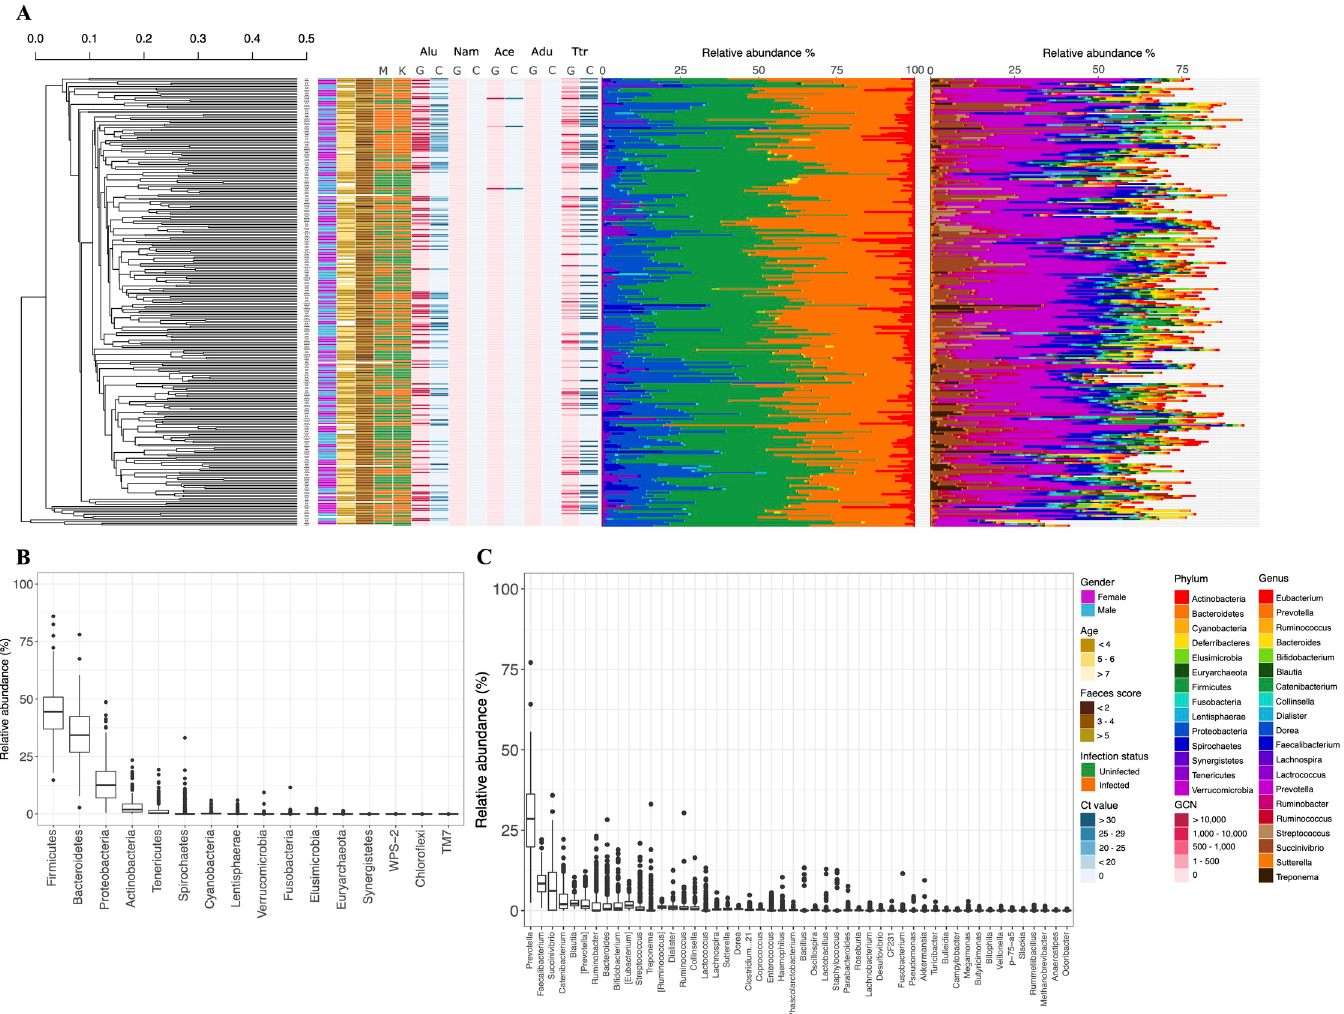
Fig 1. Bacterial gut community abundance to phyla and genera level, hierarchical clustering, soil-transmitted helminth infection status by microscopy (Kato Katz thick smear) and multiplexed-tandem qPCR (MT-PCR), sex, age and faecal score are depicted in the above figure (A) (adapted from Rosa et al . 2018 [11]). Infection intensity classification is depicted in MT-PCR gene copy number output and cycle threshold (Ct) values separated after species-specific infections: Ascaris lumbricoides (Alu), Necator americanus (Nam ) , Ancylostoma ceylanicum (Ace), Ancylostoma duodenale (Adu) and Trichuris trichiura (Ttr) (from left to right). Scale bar represents evolutionary distance. Relative abundance is visualised in percentage of all bacterial phyla (B) and the top 50 bacterial genera (C). Abbreviations within the figure for schools are KK: Krae Khi, MN: Mae Nil, MNK: Mae Nil Khi, HM: Huay Manhok, HMK: Huay Manhok Khi, MSK: Mae Salid Khi, MK: Mae Kho, MSN: Mae Salid Noi, MS: Mae Song, MSL: Mae Salid Luang and TMKT: Thi Mo Ko Tha; and for diagnostics K: Kato Katz thick smear, M: MT-PCR, G: gene copy number and C: Ct